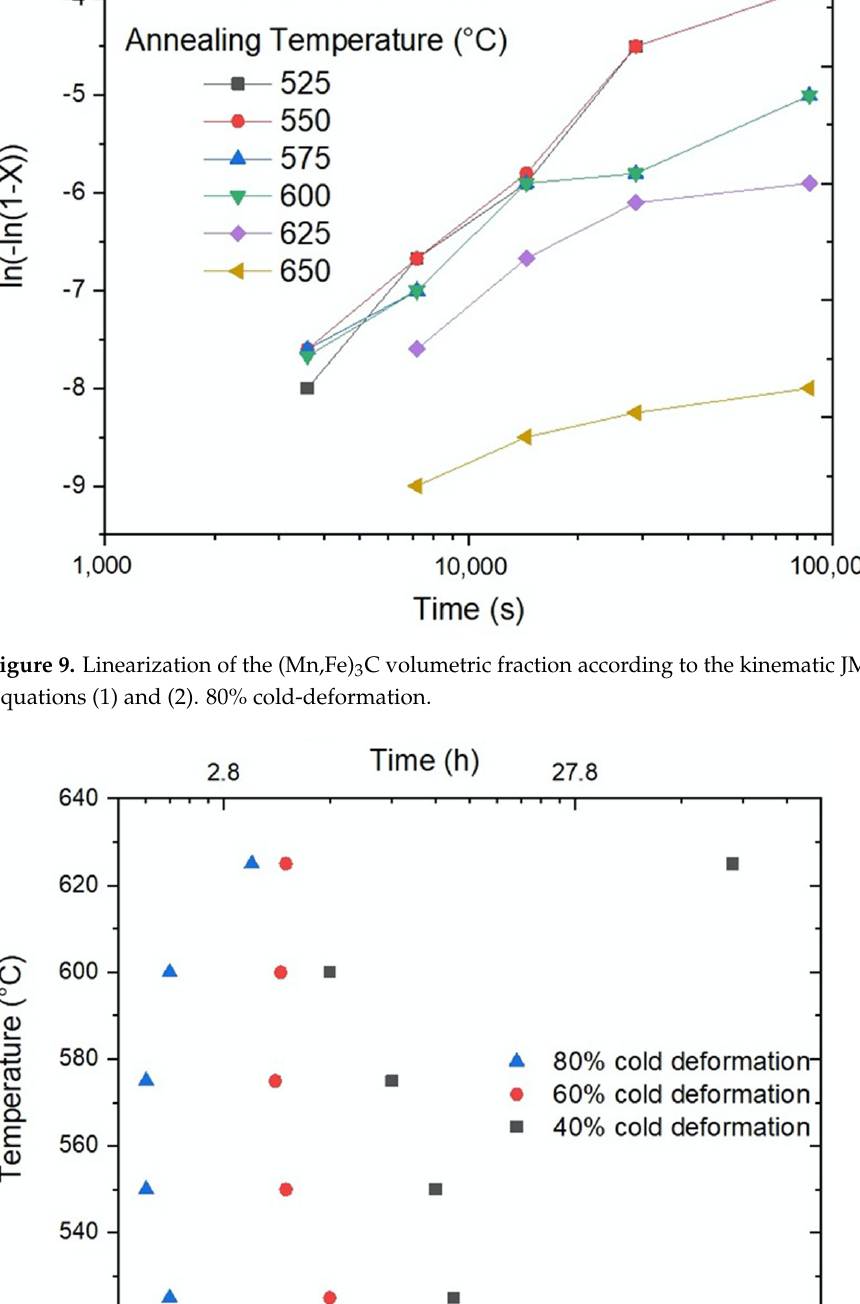
Figure 11. Evolution of (Fe,Mn) 3 C size with annealing temperature for different cold-deformation levels. Figure 12 shows the Vickers microhardness of austenite after annealing at different temperatures, deformation levels and annealing times. The initial microhardnesses for samples with 40%, 60% and 80% cold-deformation were 390, 475 and 550 HV, respectively.